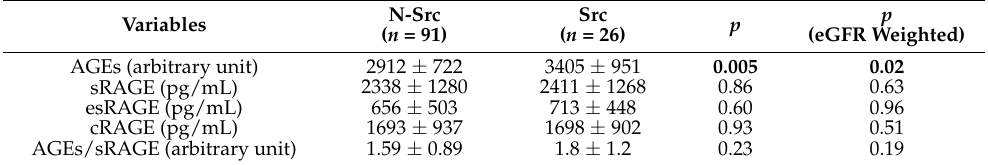
Table 2. Concentration of AGEs and sRAGE isoforms in sarcopenic and non-sarcopenic CKD